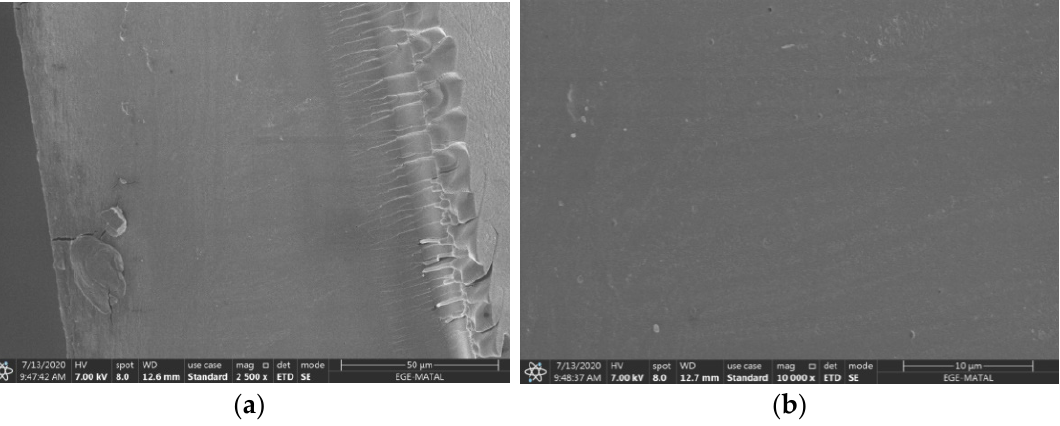
Figure 5. Cross-section SEM images of ER4-BR1.07 AEM ( a ) 2500×, ( b ) 10,000×.